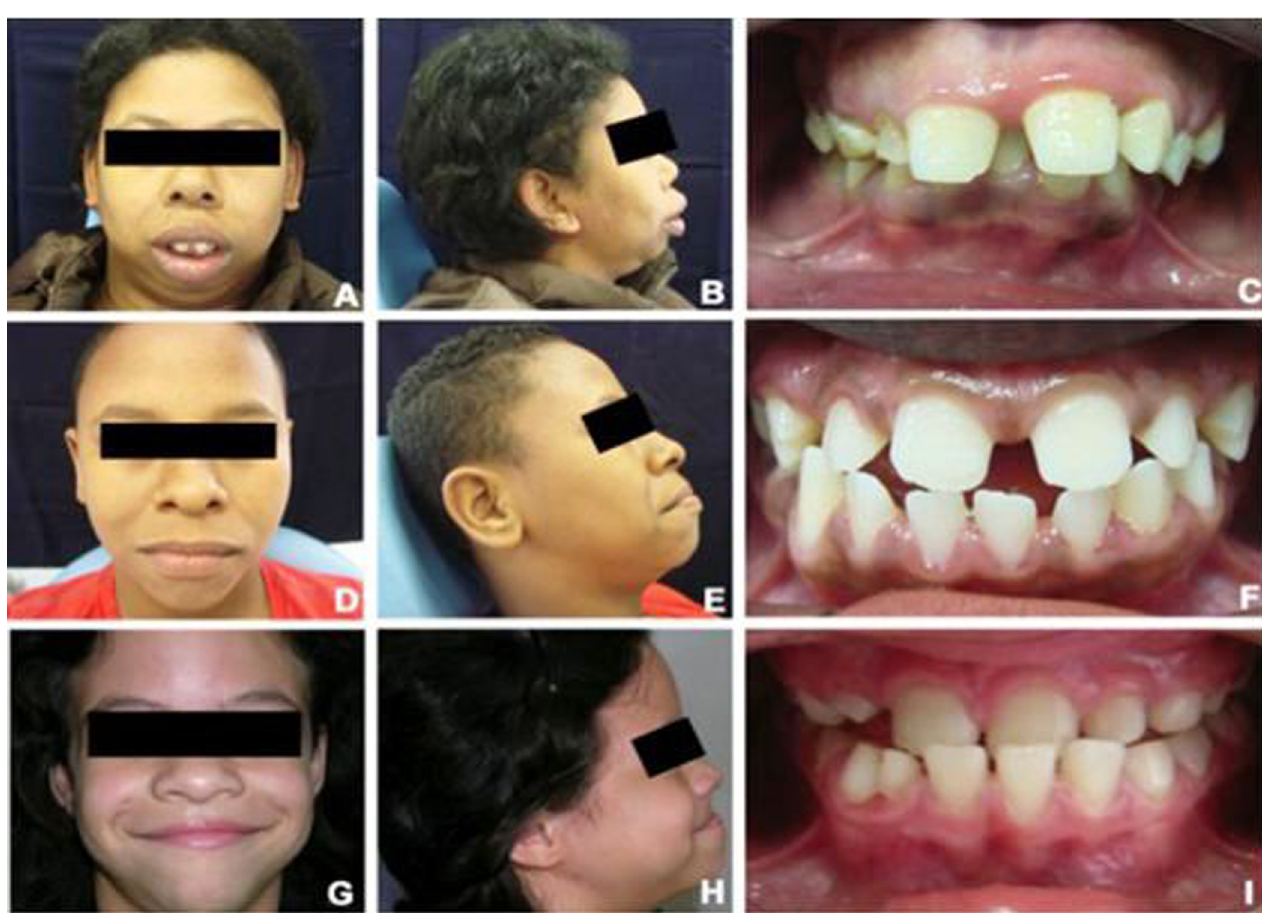
Fig. 1. Facial and dental features of WBS. (A and B) Skeletal class II malocclusion, mandibular retrognathism, dental biprotrusion, thick lips. (C) deep bite, overjet, screwdriver shaped incisors and diastema. (D and E) thick lips, and small chin. (F) cross-bite, dental biprotrusion, and diastemas. (G and H) front and lateral pictures showing wide mouth, midface fl attening. (Reprinted from Castro T, de Paula Martins Santos C, de Oliveira Lira Ortega A, Gallottini M. Oral characteristics and medical considerations in the dental treatment of individuals with